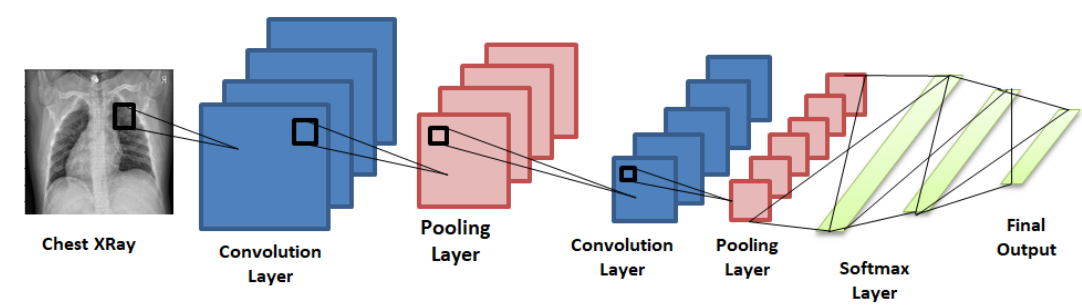
Figure 1. Convolutional neural network consisting of convolution and pooling layers and fully connected Softmax layers at the end to give the final